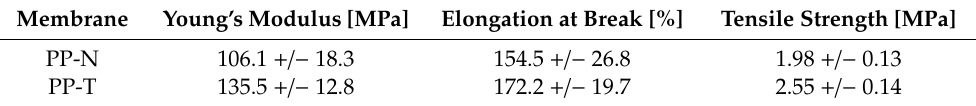
Table 2. The mechanical properties of studied PP membranes.